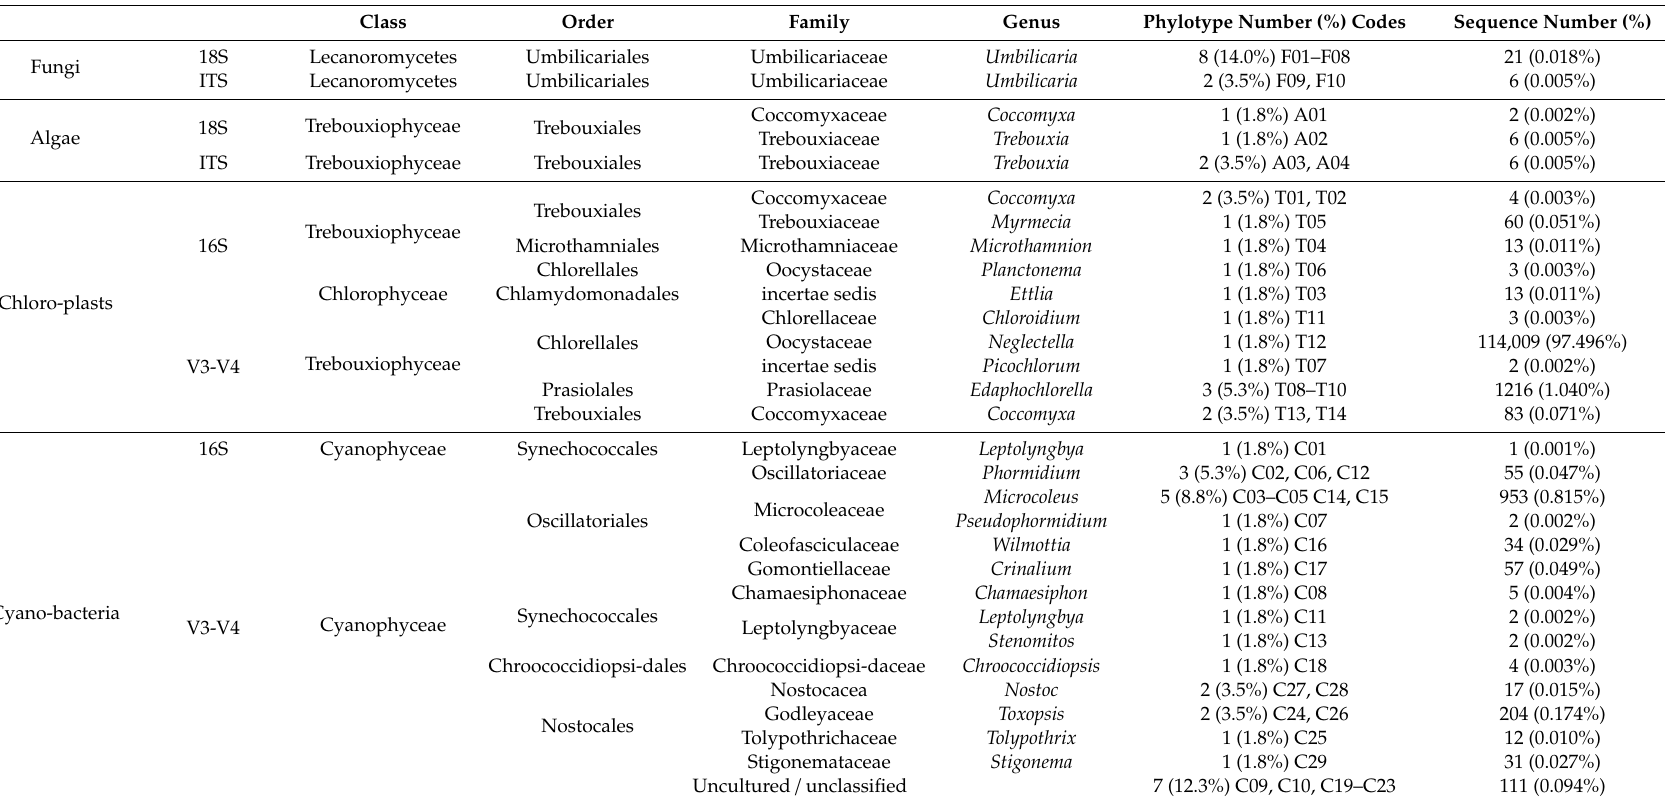
Table 3. Numbers of phylotypes and phylotype-composing sequences a ffi liated with the most closely related taxa by